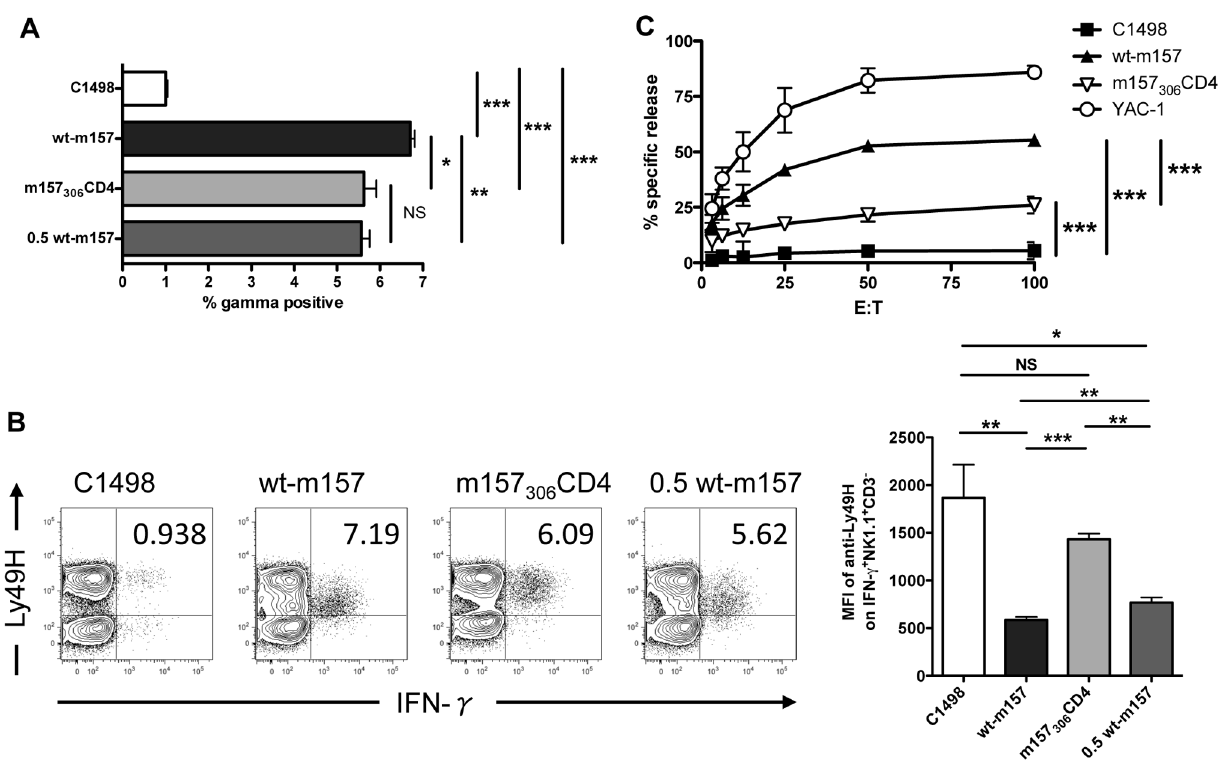
Figure 3. Transmembrane m157 expression impairs NK cell Ly49H receptor downregulation and cytotoxicity, but not IFN- c production. C1498 transfectants were incubated with B6 RAG1 2 / 2 splenocytes. (A) IFN- c production of NK1.1 + CD3 2 Ly49H + gated cells was determined by flow cytometry. (B) Representative plots showing downregulation of Ly49H, and mean fluorescent intensity of Ly49H on NK1.1 + CD3 2 IFN- c + cells (bar graph). Numbers in upper right quadrant are equal to the frequency of IFN- c + cells of Ly49H + NK cells. NS, not significant ( P . 0.05); * P , 0.05; ** P , 0.005;*** P , 0.001 (two-tailed unpaired Student’s t-test). (C) NK cell cytotoxicity against m157 transfectants was determined by chromium release assay. B6 RAG1 2 / 2 splenocytes were incubated with Cr 51 -labeled targets at indicated ratios. *** P , 0.001 (two-way ANOVA with Bonferroni post-tests). Data are representative of at least two independent experiments (error bars A, B, depict SEM).